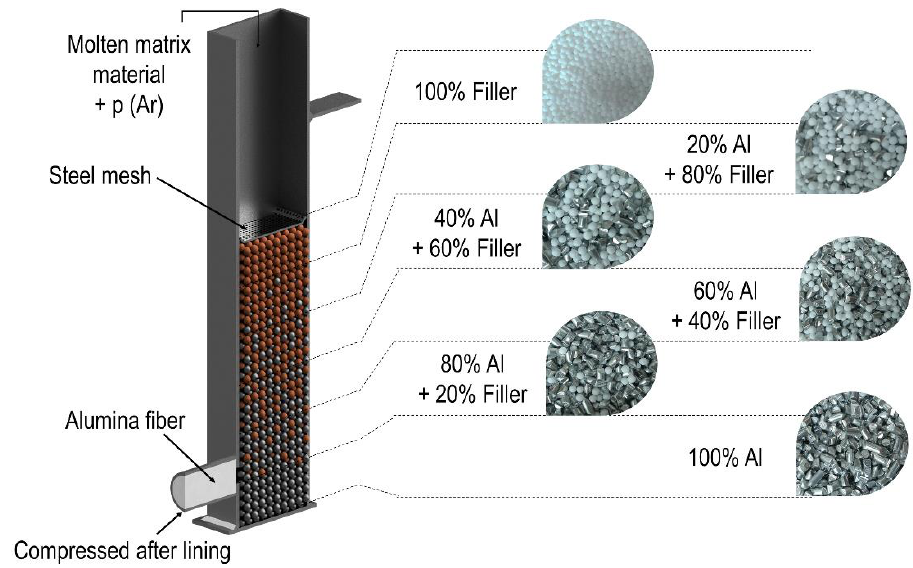
Figure 1. The closed section was filled with an adequate amount of filler material to realize the different filling distributions (0-100 sample).